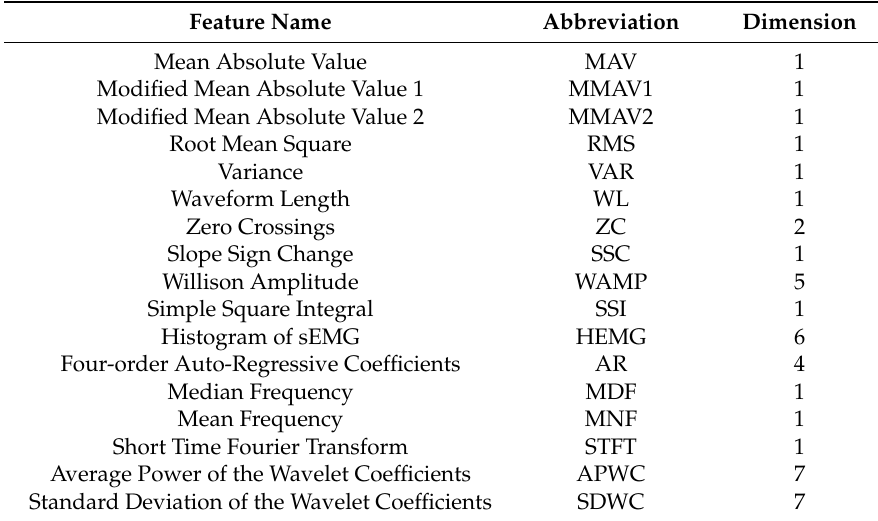
Table 1. List of sEMG features and